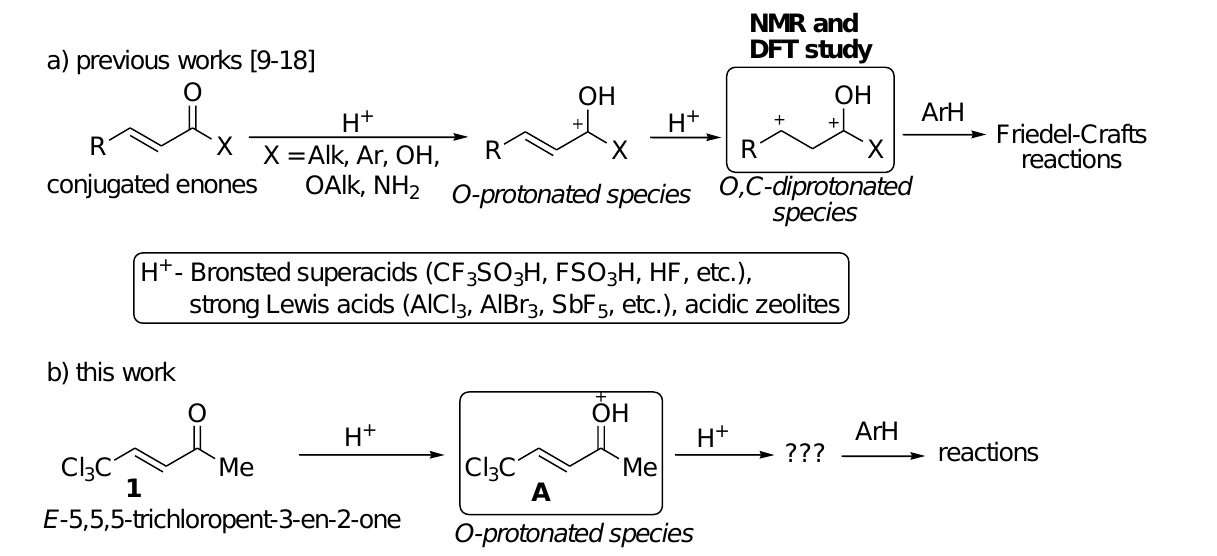
Table 1. 1 H and 13 C NMR data of CCl 3 -enone 1 (in CDCl 3 ) and its O-protonated form A (in Brønsted acids). Compound 1